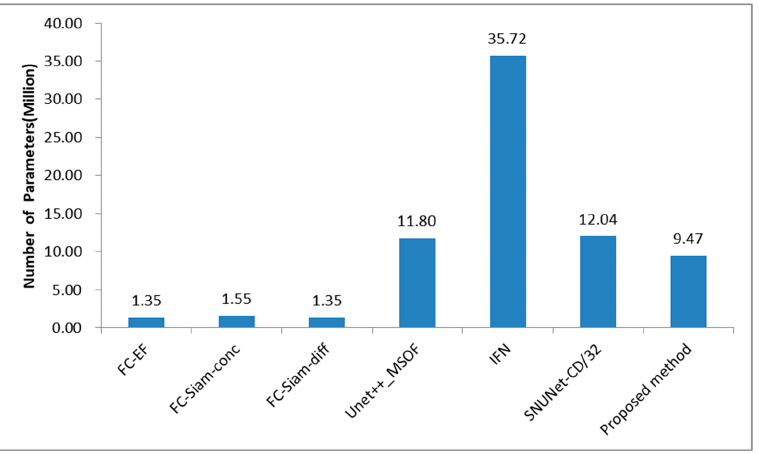
Figure 11. Comparison of network parameters of different methods.